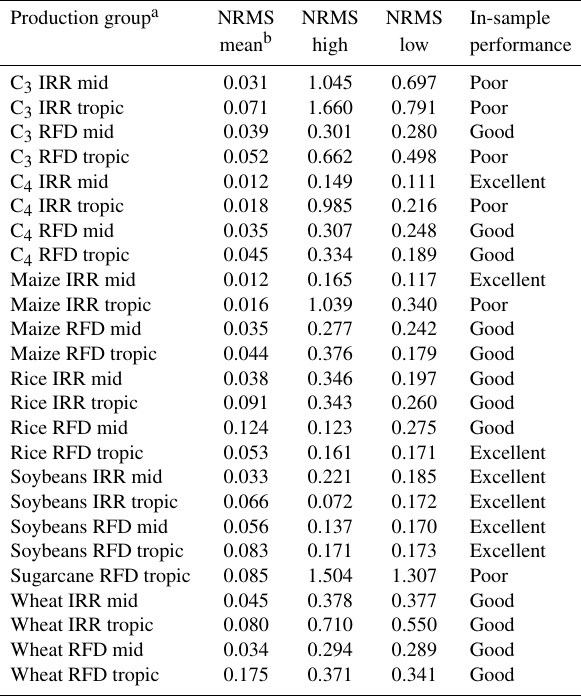
Table A8. Persephone v1.0 response function performance for